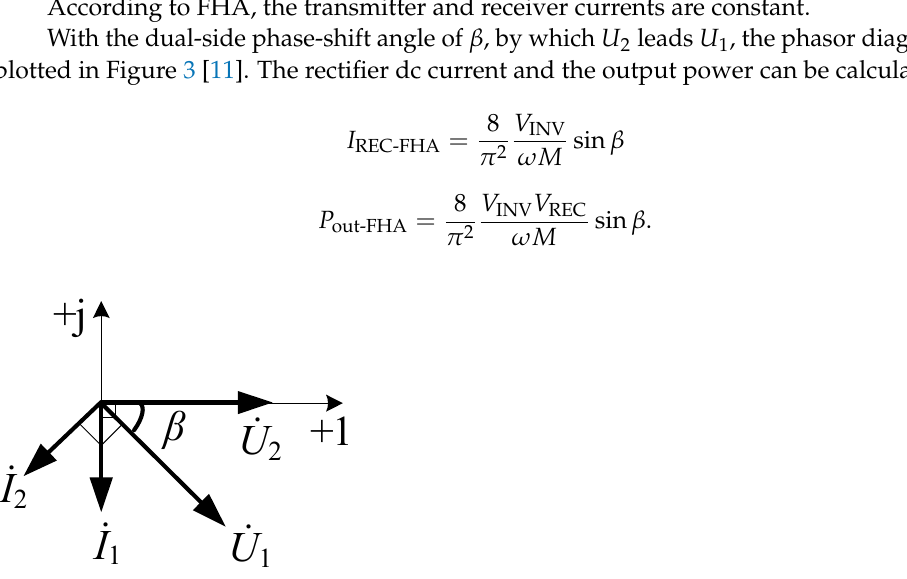
Figure 3. Phasor diagram of series–series compensated WPT system based on FHA.